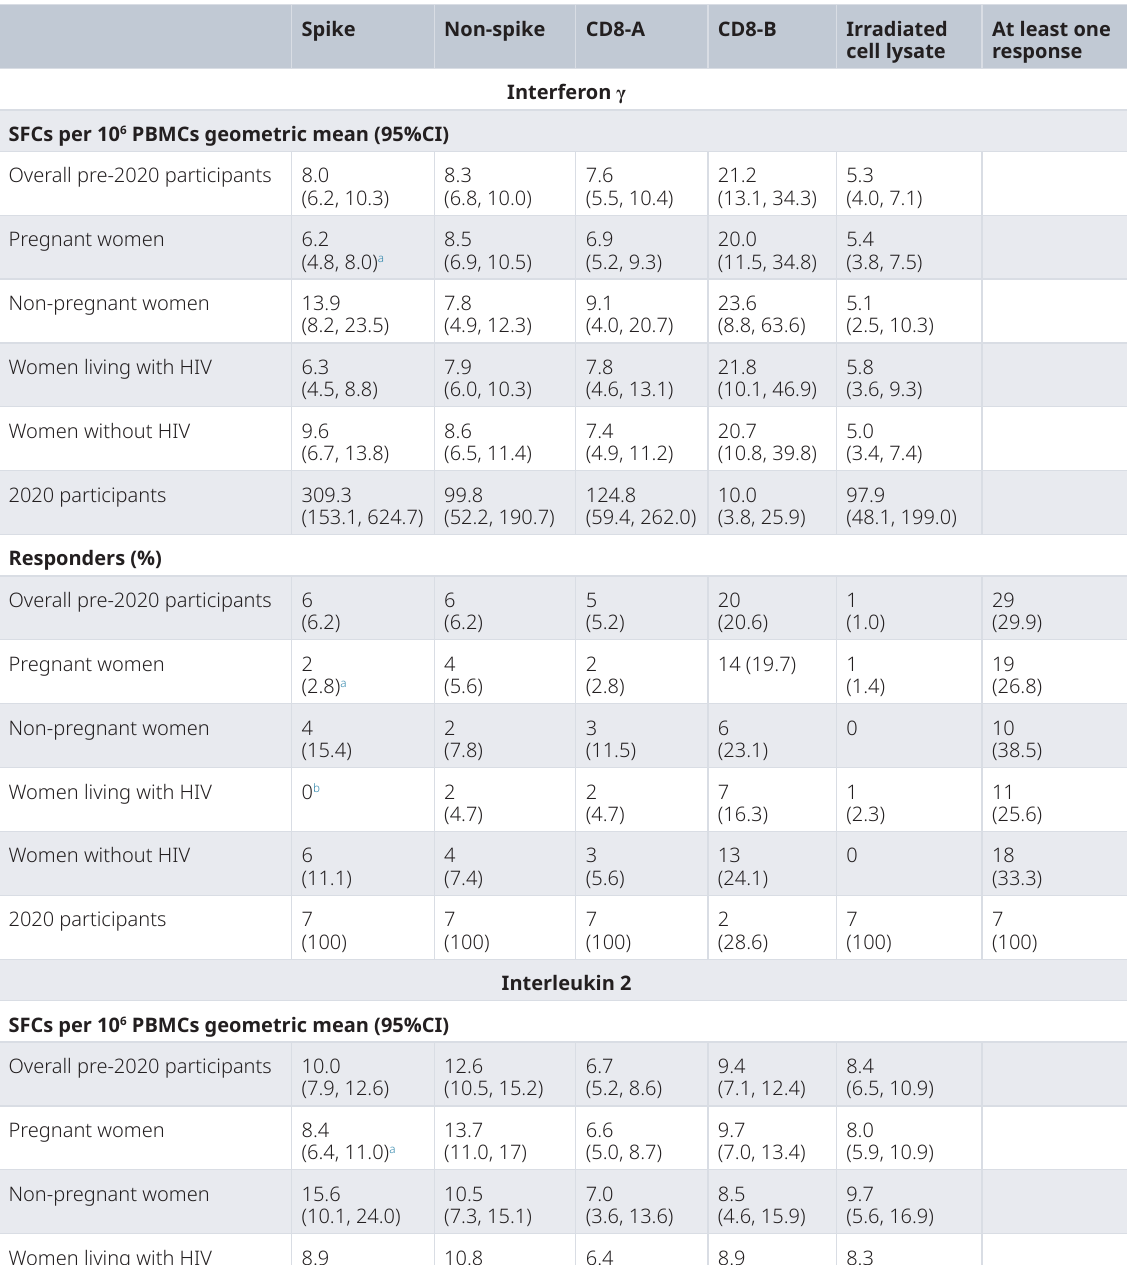
Table 2. Interferon γ and Interleukin 2 responses assessed as number of spot-forming-cells or percentage of responders among study participants after stimulation with SARS-CoV-2 peptide pools and whole virus. Spike Non-spike CD8-A CD8-B Irradiated At least one cell lysate